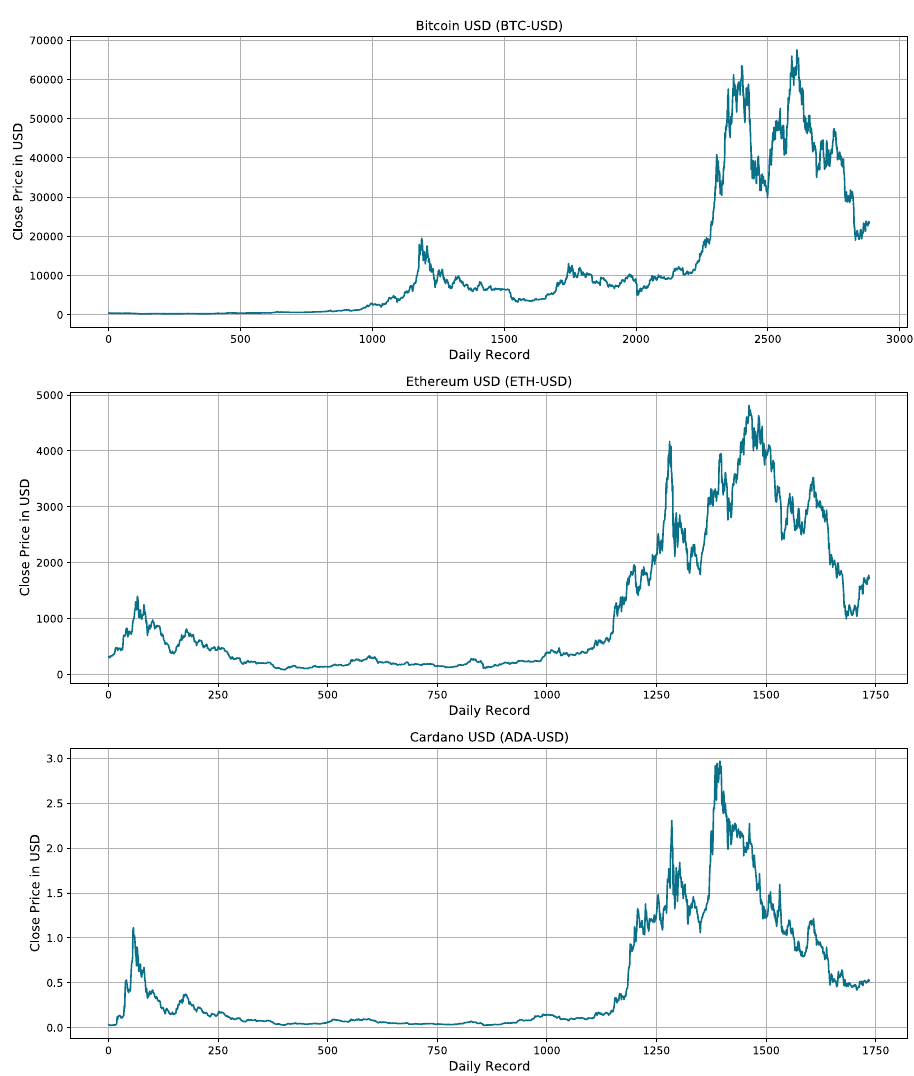
Fig. 4 The close prices summarization for the